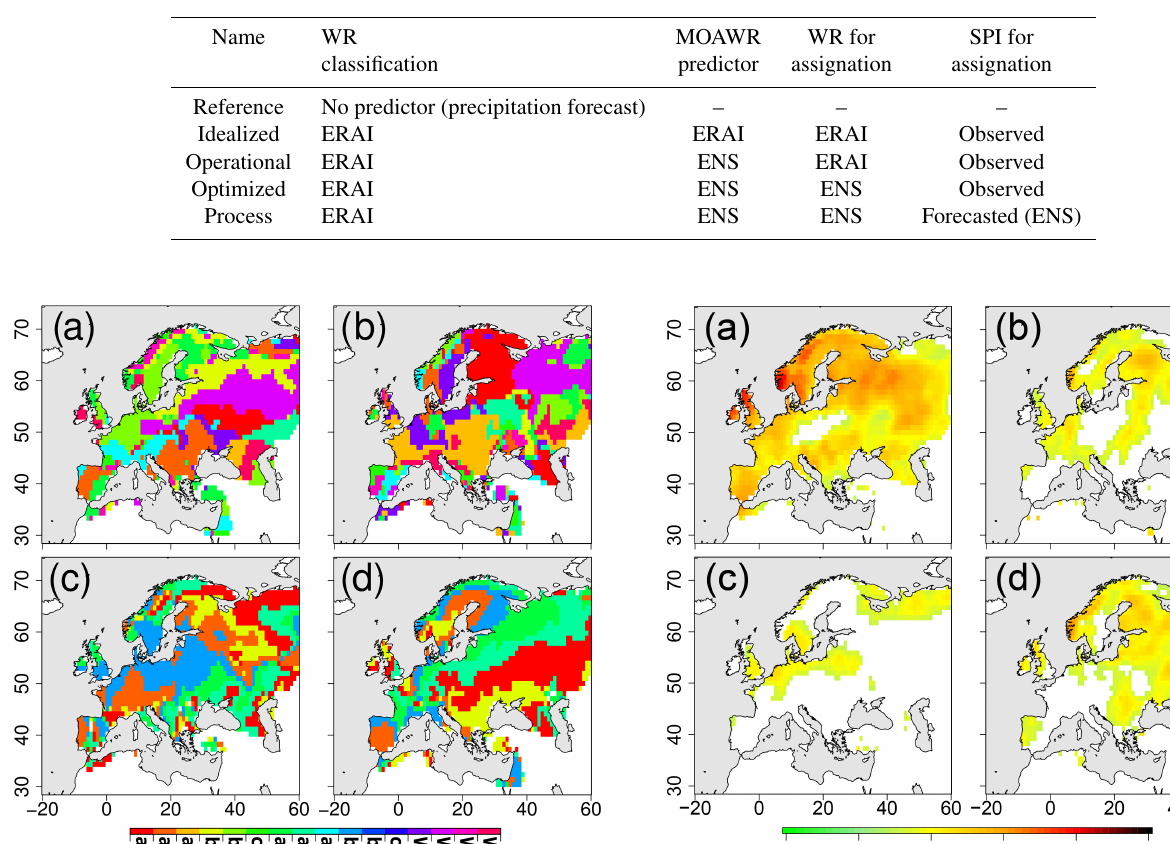
Table 3. Definition of the five sets of forecasts compared in that study. The differences are based on whether a predictor is used or not, the use of predictors derived from reanalyze or forecasted and for the assignation procedure, the use of observed or forecasted SPI.